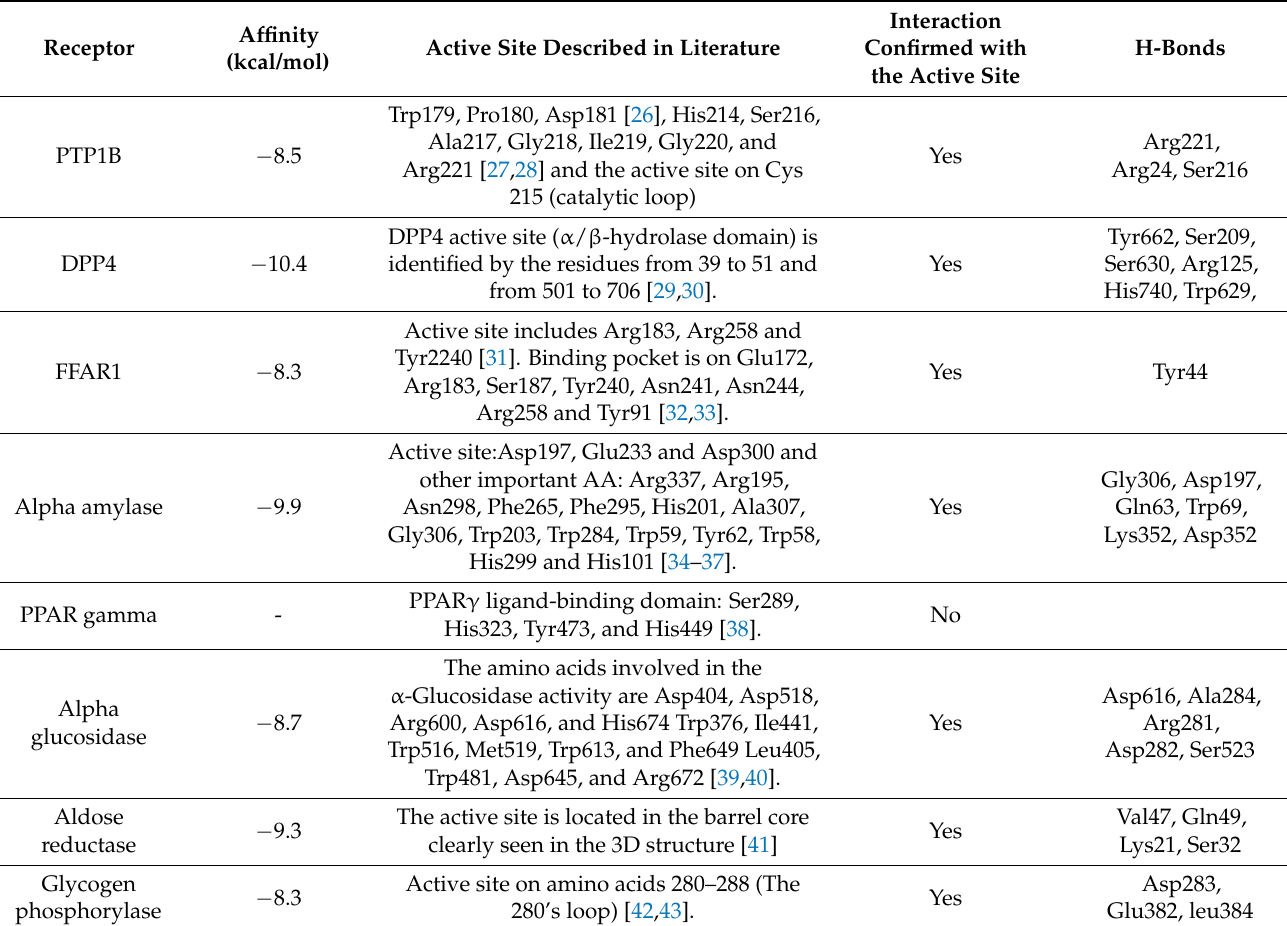
Table 1. Summary of narirutin/receptors